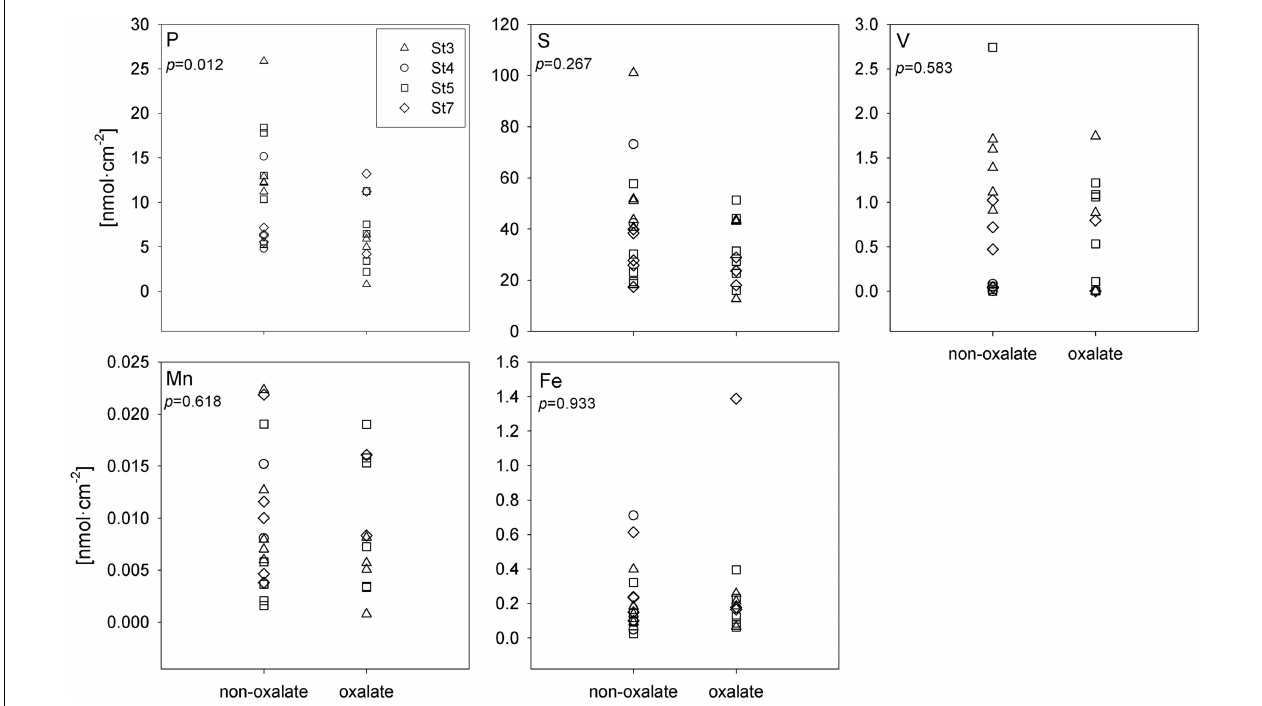
FIGURE 6 | Comparison of SXRF-analyzed trichome sections with or without oxalate treatment to remove externally bound elements. Areal concentrations are presented in nmolcm − 2 . Each station has its unique